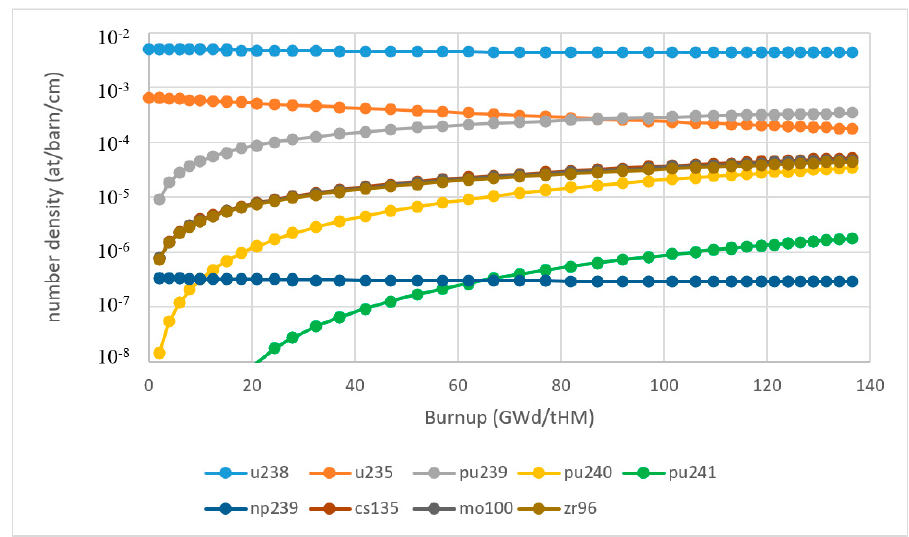
Figure 6. Criticality over burnup for the temperature varied system with the criticality given on the left axis and the system averaged temperature on the right axis for the close to eutectic system.